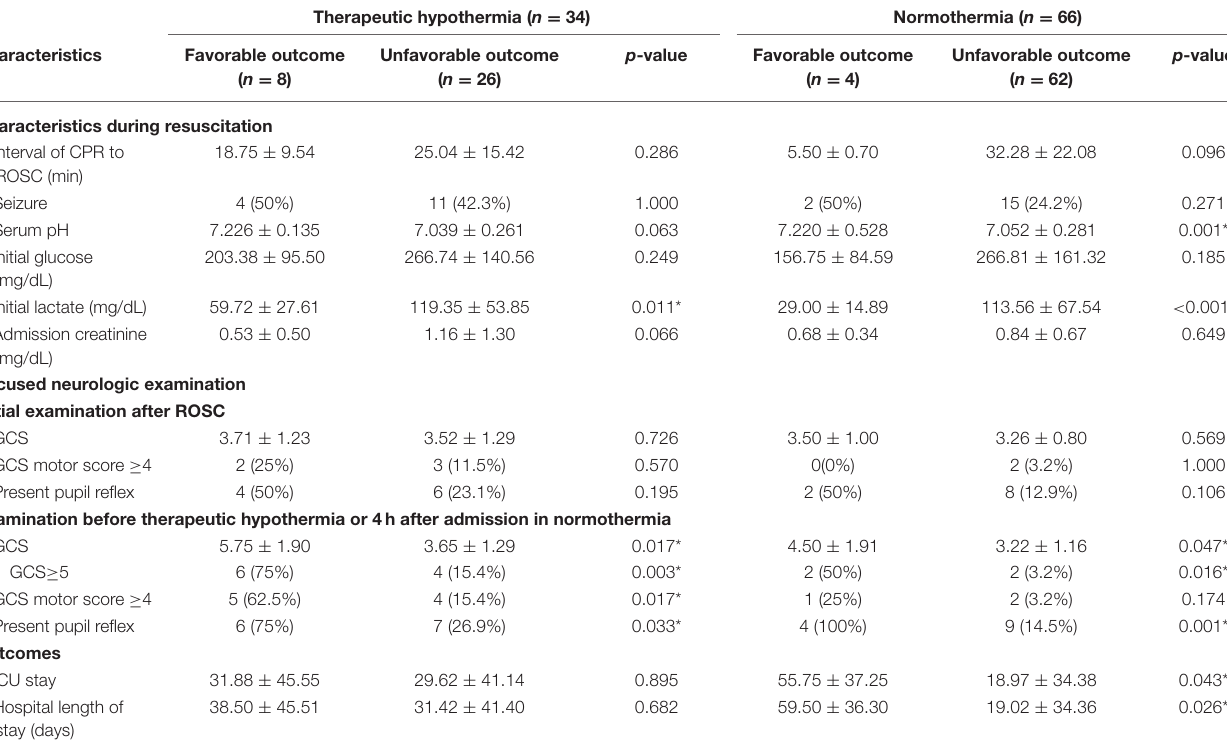
TABLE 2 | Variables during and after resuscitation of the 100 asphyxial out-of-hospital cardiac arrest children receiving therapeutic hypothermia and normothermia.